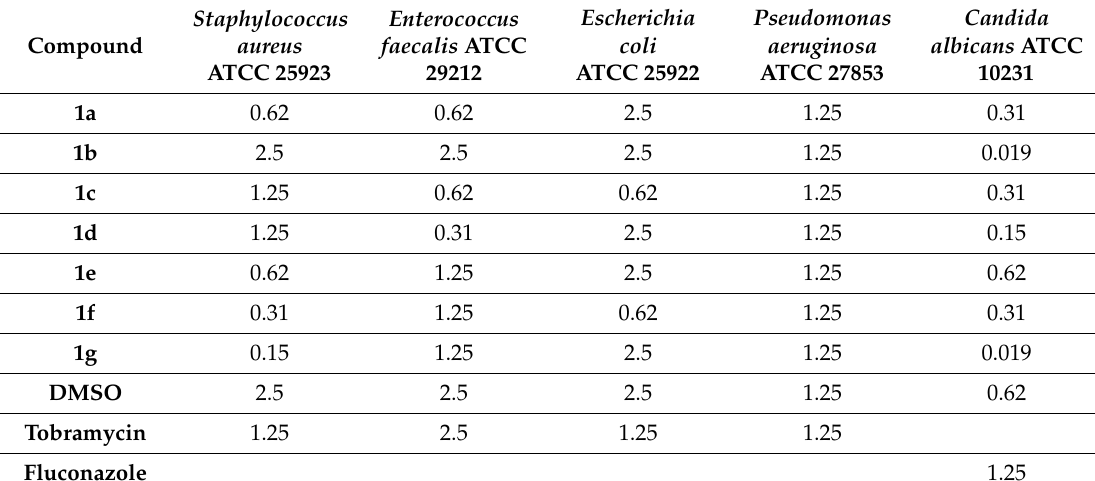
Table 6. Results of the anti-biofilm assay of MBEC for the compounds 1a – g . (MBEC values expressed in mg /